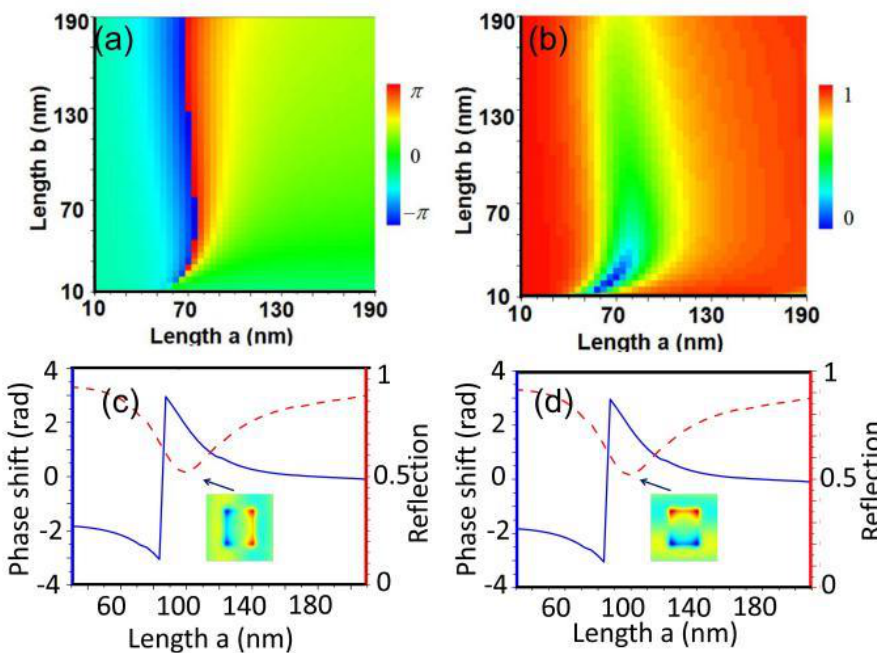
Figure 2. ( a ) Phase and ( b ) reflectance of the reflected light for x-polarization incidence with different lengths b and a . Phase shift and reflectance of reflected wave for ( c ) x- and ( d ) y-polarization incidences. Insets are z-component electric field distributions corresponding to ( c ) horizontal dipole and ( d ) vertical dipole.